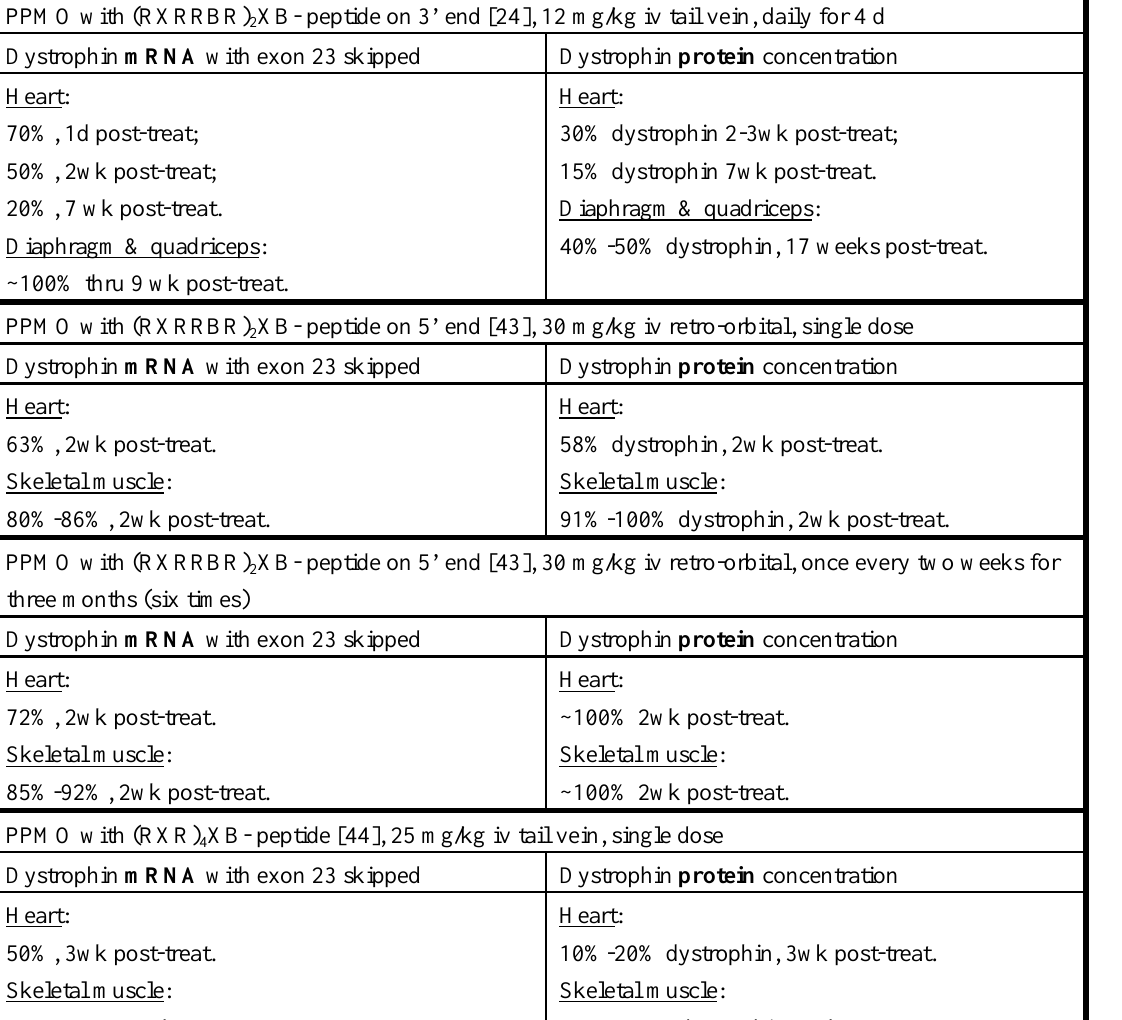
Table 1. Comparison of systemic delivery of PPMOs for